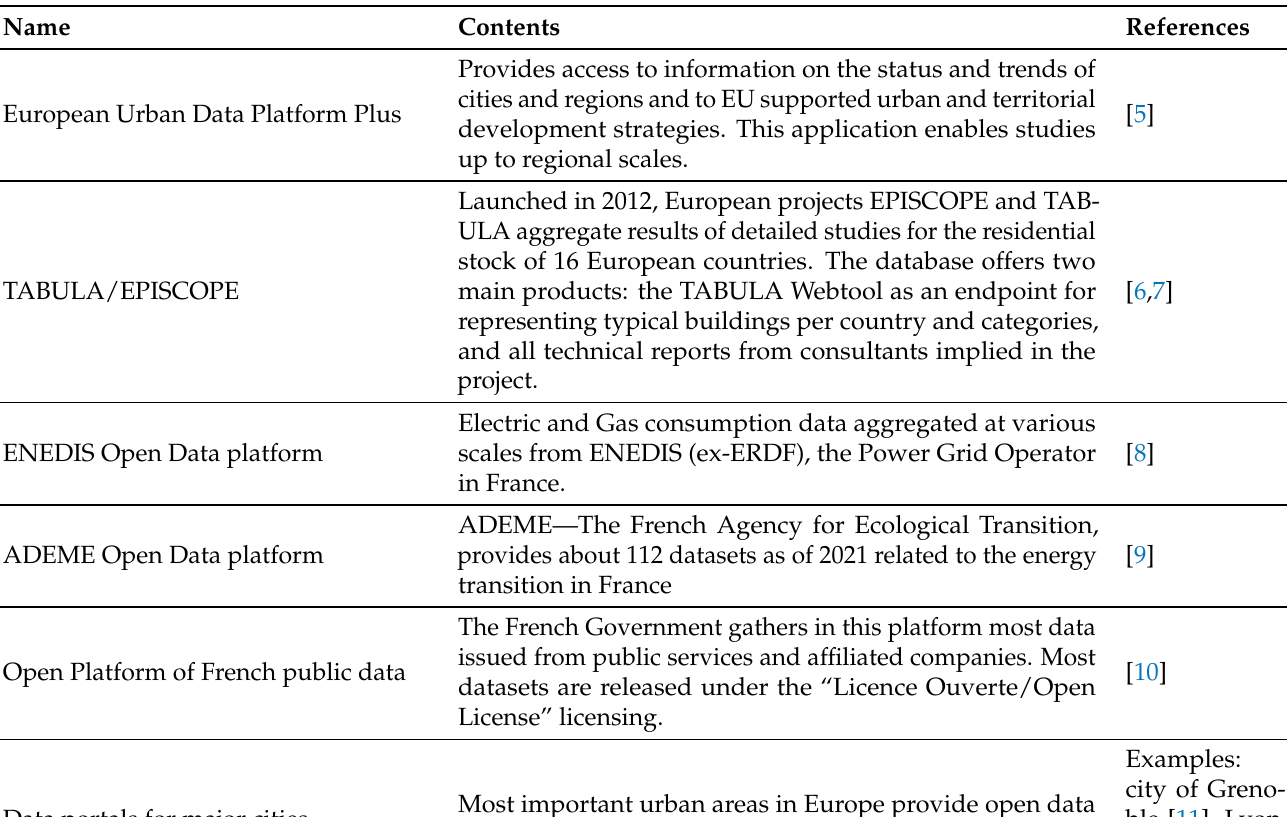
Table 1. Open data sources examples for energy and